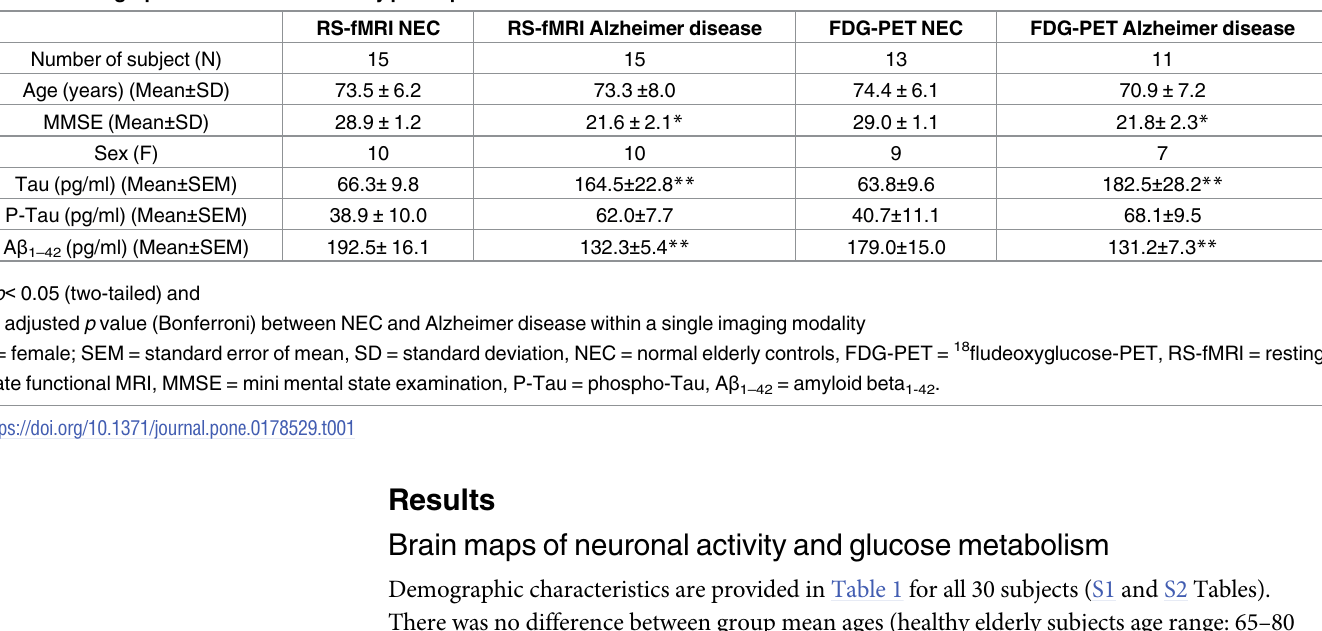
Table 1. Demographic information for study participants.